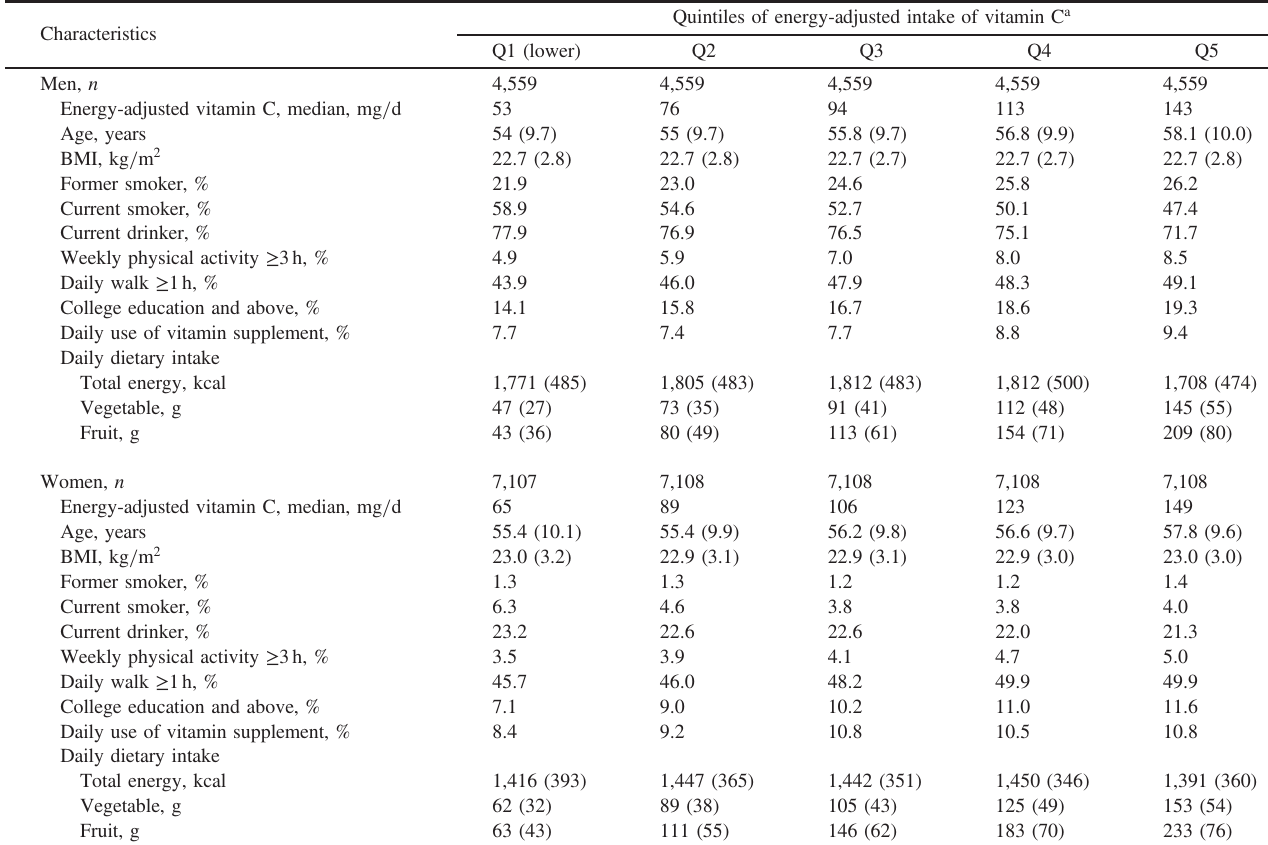
Quintiles of energy-adjusted intake of vitamin C